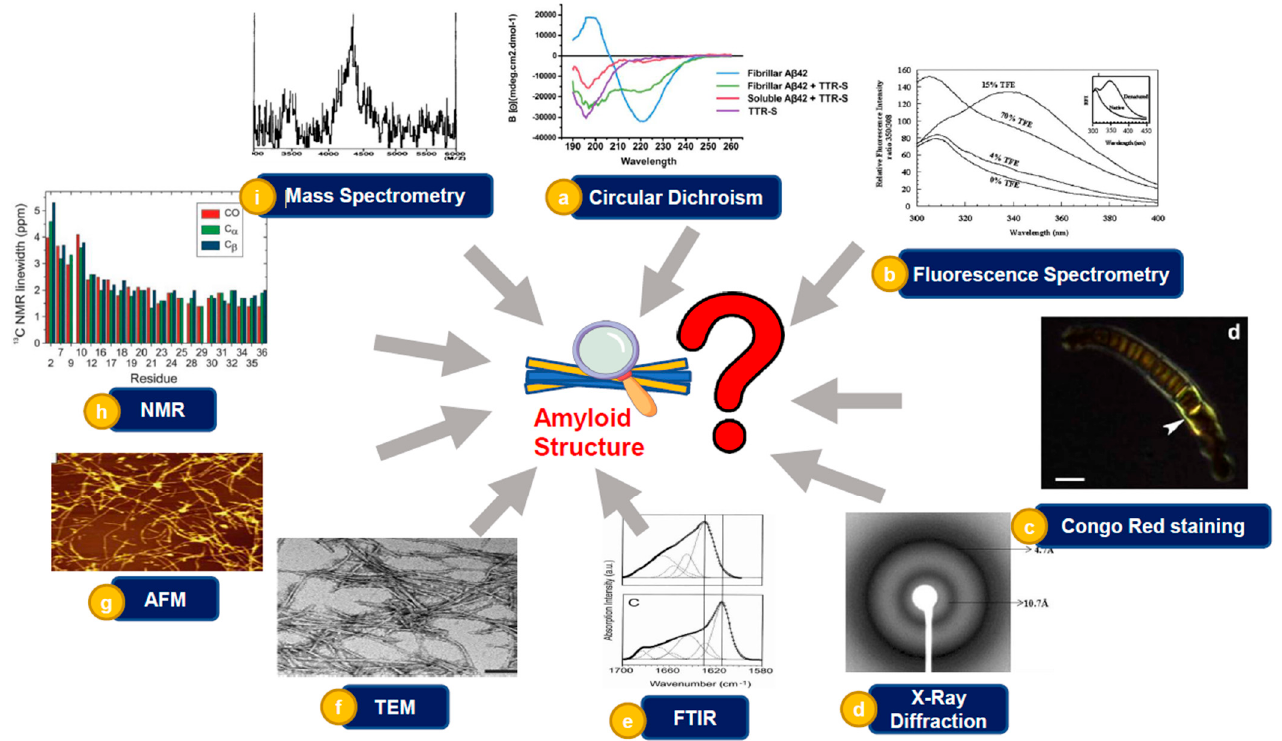
Figure 3. Common biophysical techniques used in the characterization of amyloid fibrils: ( a ): CD spectra of A β 42 fibrils in presence and absence of TTR (figure adopted from [67]; ( b ): the intrinsic fluorescence of nFGF-1 in various concentrations of TFE (the figure was adopted from reference [71]; ( c ): staining with red Congo of plant (Prasiola linearis adhesive) (the figure adopted from [76]); ( d ): the X-ray fiber diffraction of the n-FGF1 fibrils induced by TFE (the figure was adopted from reference [77]); ( e ): FTIR for native (1) and (2) fibrils TTR (the figure was adopted from [97]; ( f ): TEM